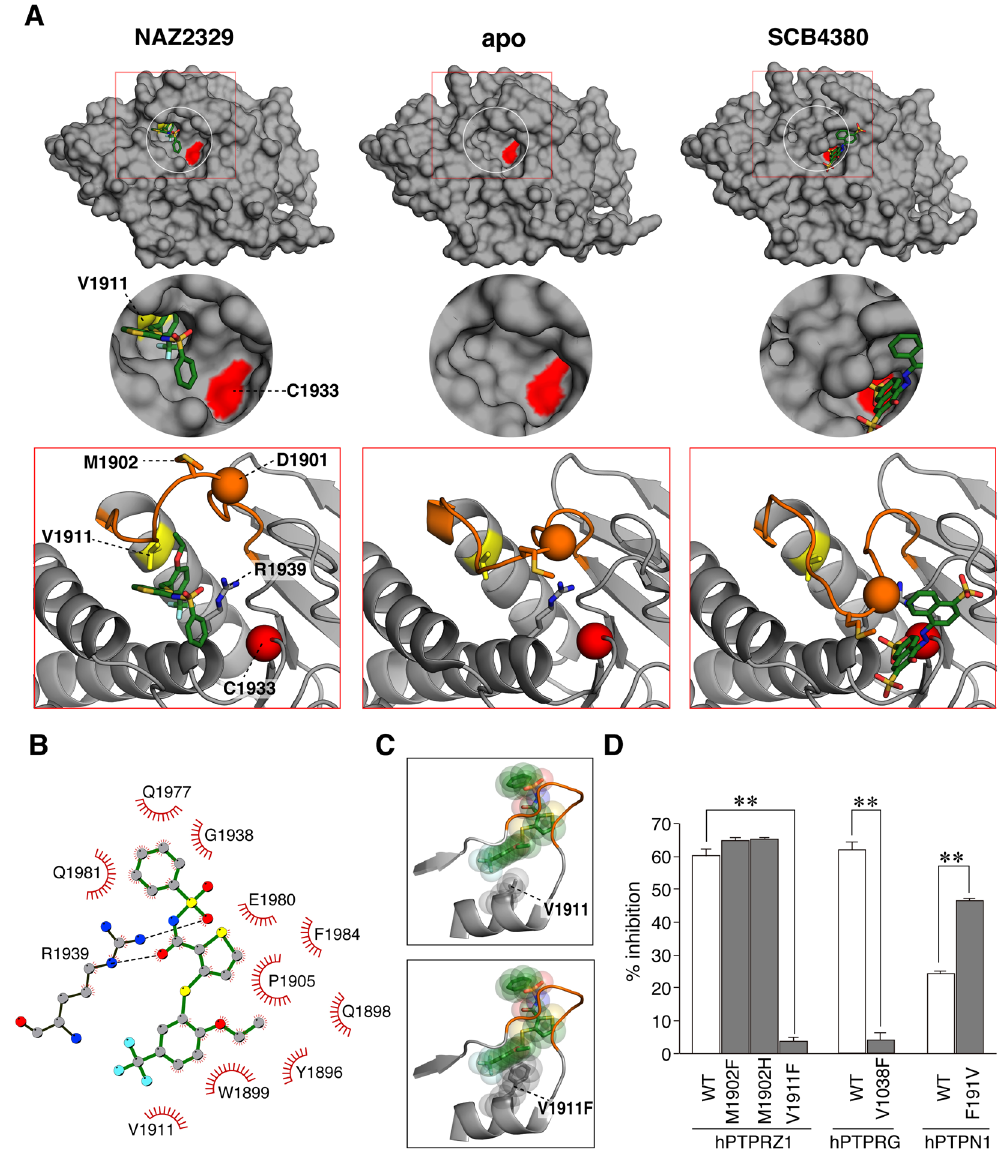
Figure 5. Structural basis for PTPRZ inhibition of NAZ2329. ( A ) An enlarged view of the X-ray structure of human PTPRZ1-D1 complexed with NAZ2329 (PDB ID: 5H08) (left), X-ray structure of the apo (open) form of PTPRZ1-D1 (PDB ID: 5AWX, ref. 6, middle) and a computer-modeled structure of the closed form of PTPRZ1-D1 complexed with a competitive inhibitor, SCB4380 (ref. 6, right), are shown. PTPRZ1-D1 is shown as a gray surface representation, in which Cys1933 at the active site and Val-1911 at the bottom of the allosteric pocket are indicated in red and yellow, respectively. Inhibitors are colored according to the atomic species in a stick figure representation as follows: oxygen (red), nitrogen (blue), sulfur (yellow), and carbon (green). The bottom figures show the conformation of the WPD loop (orange) as cartoon representations, in which Asp1901 and Cys1933 are indicated by orange and red spheres, respectively. Side chains of Arg1939 at the active site, Met1902 in the WPD loop, and Val-1911 at the bottom of the allosteric binding area are also shown in the stick representation. ( B ) LigPlot representation of the NAZ2329 interaction with PTPRZ1-D1. The predicted hydrogen bonds (broken black lines) and residues (red spoked arcs) involved in the hydrophobic interaction are shown. ( C ) Predicted steric hindrance toward NAZ2329 binding after substitution of Val-1911 with a bulky Phe residue. The wild-type (upper) and replaced (lower) structures of PTPRZ1-D1 are shown in stick and transparent-sphere models. The structure was built by direct replacement of Val-1911 by Phe using the mutagenesis tool in the PyMOL software. ( D ) Inhibitor sensitivity to point substitution mutants of PTPs. Inhibition by 10 µ M NAZ2329 is presented as a percentage of the DMSO control for each enzyme (mean ± S.E. of three separate experiments). ** P < 0.01, significantly different from the wild-type enzyme (Student’s t